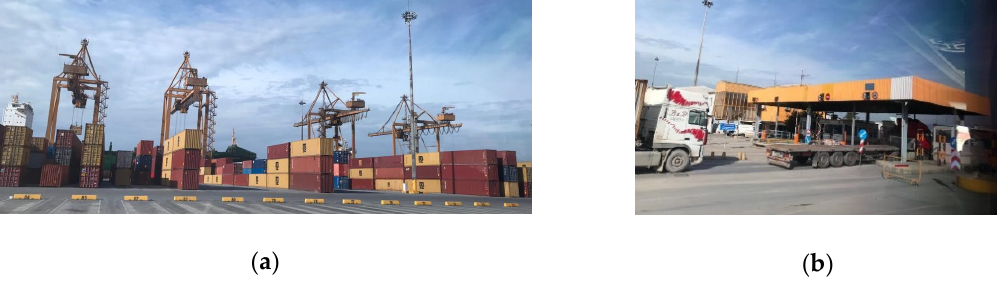
Figure 5. Setup of the use-case. Port-City of Thessaloniki and its interface. ( a ) Picture of cranes of the ports’ container terminal; ( b ) One of the truck gates of the port.